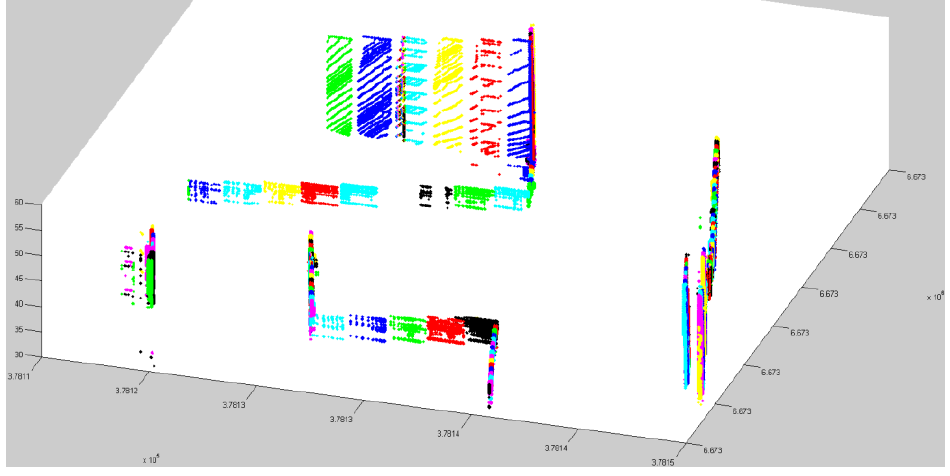
Figure 12. Detection of coplanar point detection (different colors represent different